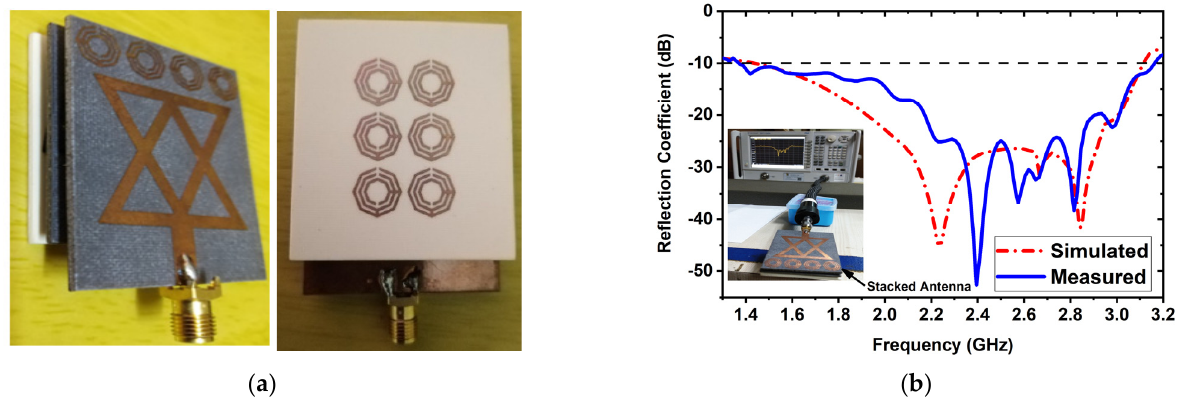
Figure 1. ( a ) Fabricatted 3D stacked antenna, ( b ) Measured and simulated reflection coefficient.